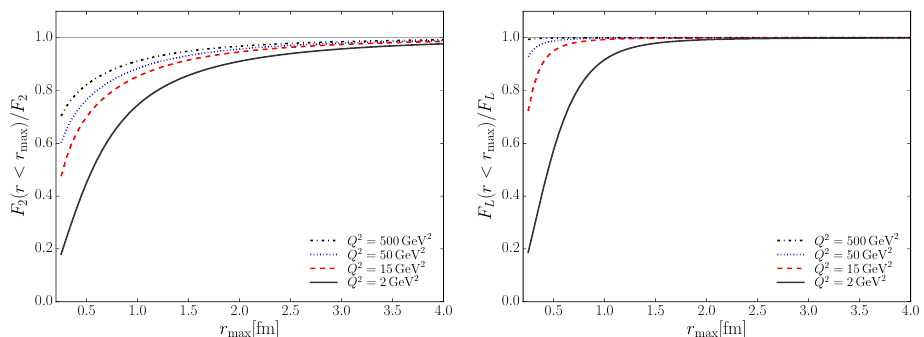
Figure 14. Contribution to the structure functions F 2 ( left ) and F L ( right ) from dipole sizes smaller than r max at different photon virtualities. F L sensitivity to large dipoles is reduced compared to F 2 due to the different structure of light-cone wave functions between longitudinally and transversely polarized photons. Figure from the work in